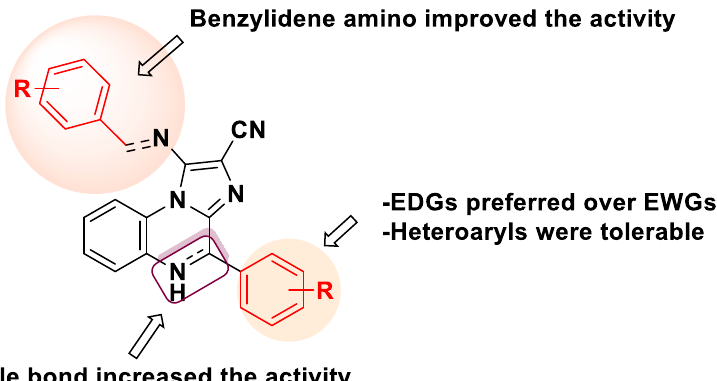
Figure 3. Illustration depicting the structure-activity relationship for the synthesized series ( 5 – 11 ). Table 2. Antiproliferative potential of 6b , 7h , 7j , 9a and 9c against human cancer cells. Code